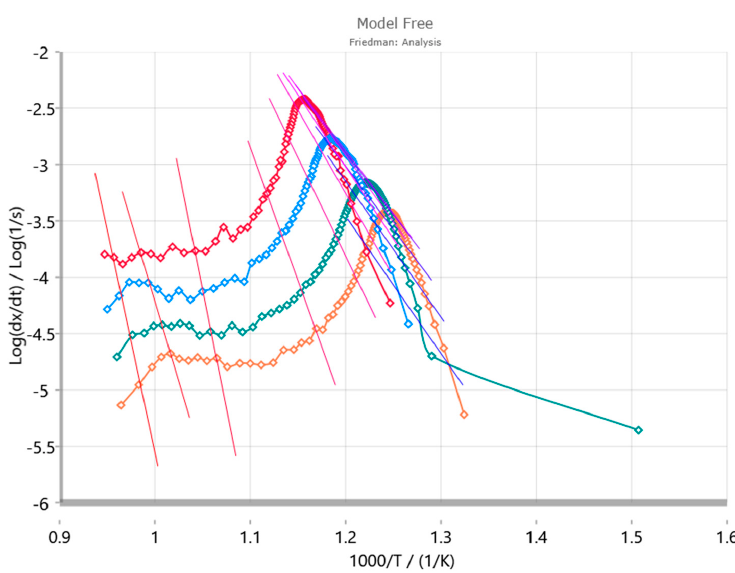
Figure 4. Friedman analysis of PEEK using 4 di ff erent heating rates under nitrogen (orange: 1 K / min, green: 2 K / min, blue: 5 K / min, red: 10 K /